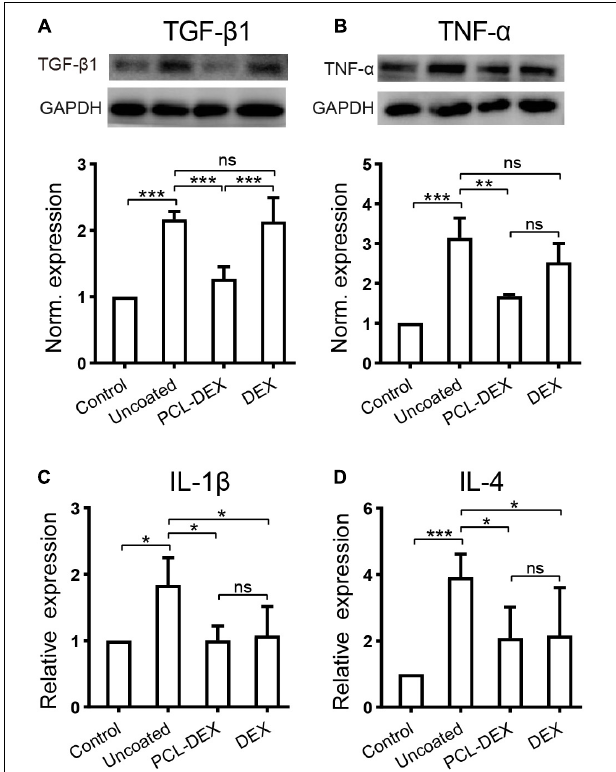
FIGURE 7 | The effects of different implant treatments on the expression of inflammatory factors in the cochlea. (A) Representative immune bands (upper panel) and normalized expression level (lower panel) of TGF- β 1 in the contralateral cochlea (control) and 7 days after different implant procedures. n = 4 for each group. (B) Representative immune bands (upper panel) and normalized expression level (lower panel) of TNF- α in the contralateral cochlea (control) and 1 day after different implant procedures. n = 4 for each group. (C) ELISA shows the normalized expression of IL-1 β in cochlear lysates 1 day after different implant procedures. n = 4 for each group. (D) ELISA shows the normalized expression of IL-4 in cochlear lysates 7 days after different implant procedures. n = 5 for each group. “Pristine” for pristine electrode implant. “PCL-DEX” for implantation with a PCL-coated (MW = 36 k) electrode containing 20% DEX. “DEX” for pristine electrode implantation with one dose of DEX applied via a round window. The experiment was repeated at least three times in each group. All data points are presented as the mean ± SD. ns: no significant difference, p > 0.05; * p < 0.05; ** p < 0.01; *** p < 0.001, Student’s t